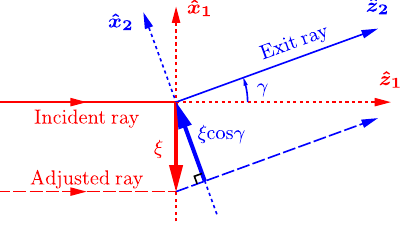
FIG. 4. Schematic of incident and adjusted rays clarifying calculation of the x-ray trajectory distorted by a misaligned optical element.